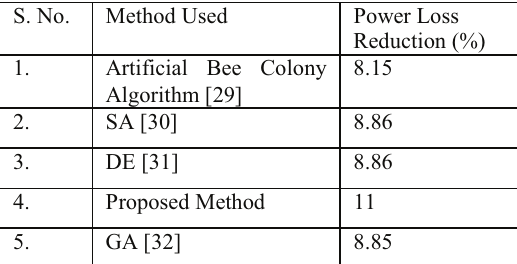
Table 2 Simulation Results of IEEE-14 Bus System S.